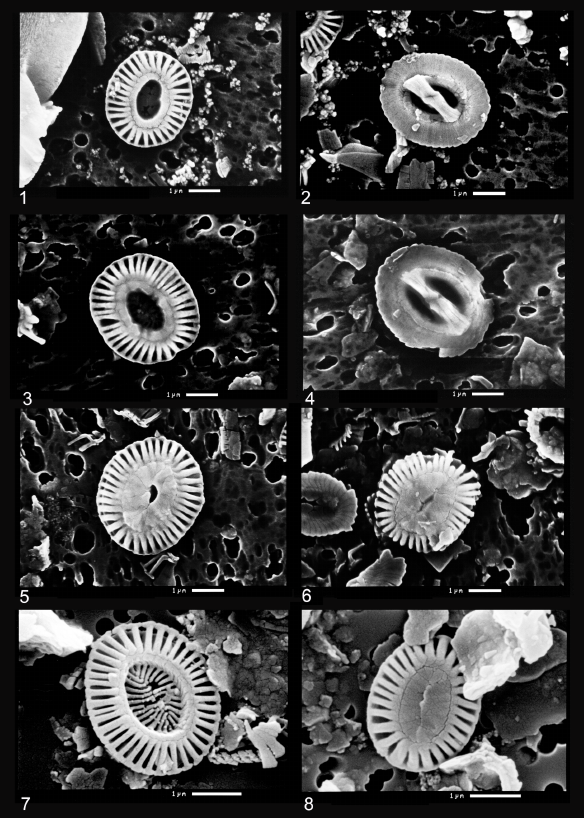
Fig. 8. SEM images of Noelaerhabdaceae coccoliths. (1) E. hux- leyi (Azores), (2) G. muellerae (Azores), (3) E. huxleyi (Rock- all Plateau), (4) G. muellerae (Rockall Plateau), (5) overcalcified E. huxleyi (Rockall Plateau, (6) overcalcified E. huxleyi (Rockall Plateau), (7) E. huxleyi (Vøring Plateau) and (8) overcalcified E. huxleyi (Vøring Plateau). All scale bars are